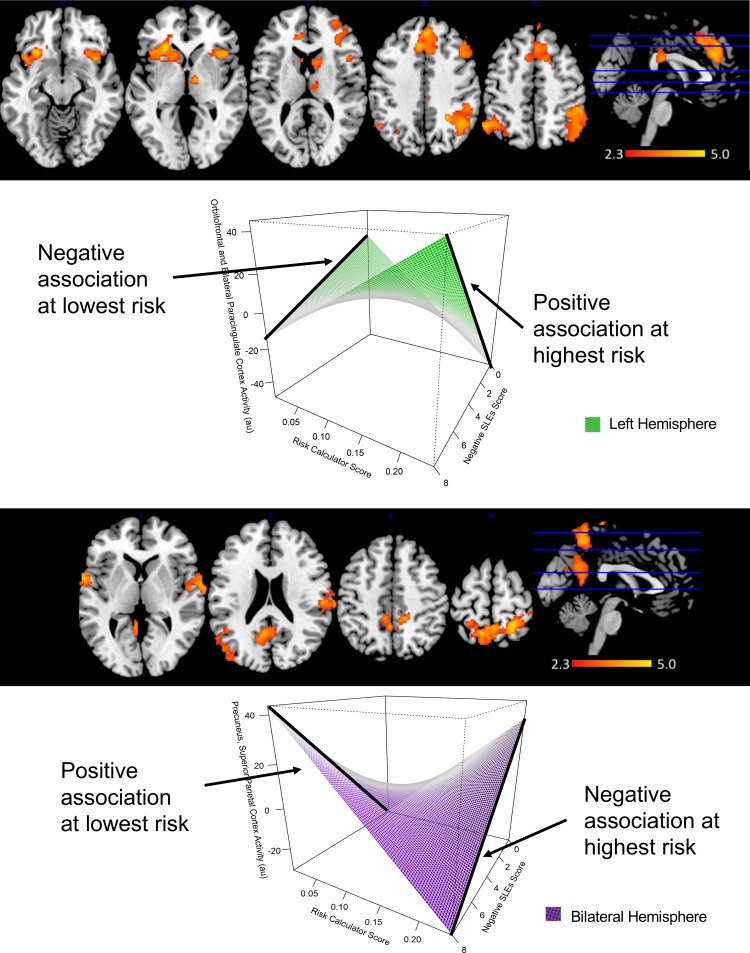
Interaction effects of risk calculator score and negative stressful life events schedule (SLES) score on whole-brain activity measures during reward processing.A) Positive interactions between risk calculator score, nSLES score and activity were found within 5 clusters. A graphical representation of these interactions has been displayed for one large cluster spanning the left orbitofrontal cortex, bilateral paracingulate, left caudate, putamen, and insular cortex. At higher risk calculator score greater positive associations between activity and nSLES score were found, while this relationship was inversed at low risk calculator score. B) Negative interactions between risk calculator score, nSLES score and activity between bilateral amygdala were found within 4 clusters. A graphical representation of this interaction is displayed one cluster spanning bilateral precuneus and superior parietal cortex. In this case, at higher risk calculator score a negative association between activity and nSLES score, while this relationship was positive at low risk calculator score. A full set of these interaction plots can be found in the supplementary. * au = arbitrary units All results were corrected for using Z-statistic threshold at z>2.3, pFWE<0.0017. A contrast of reward vs control conditions was used in all cases. Activity values were mean adjusted using a healthy control sample.